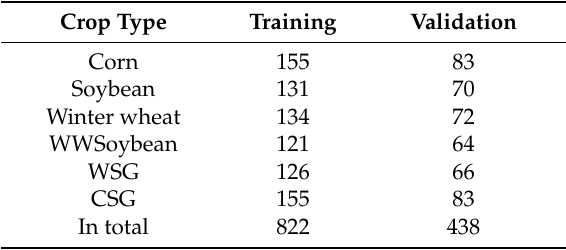
Table 2. The distribution of samples used for training and